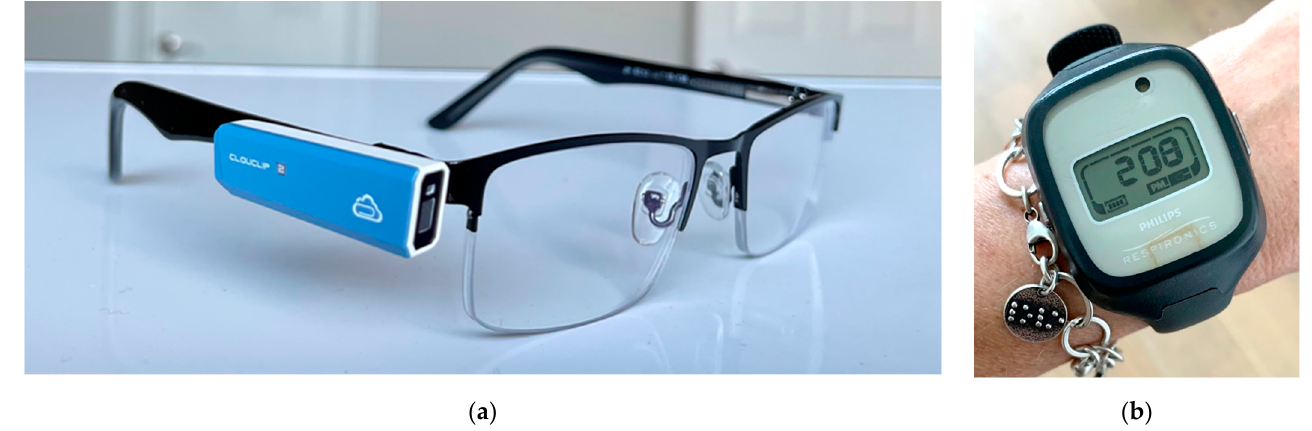
Figure 1. ( a ) Clouclip device fitted to the right temple of a spectacle frame; ( b ) Actiwatch Spectrum Plus. Table 1. Characteristics of the two sensors utilized in this study, the Clouclip and